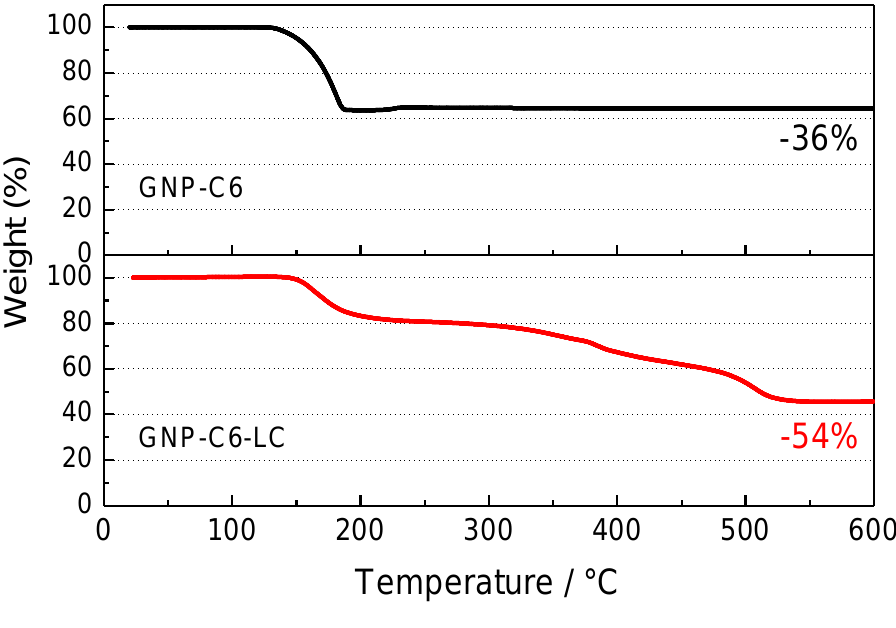
Figure 4. TG curves of GNP-C6 and